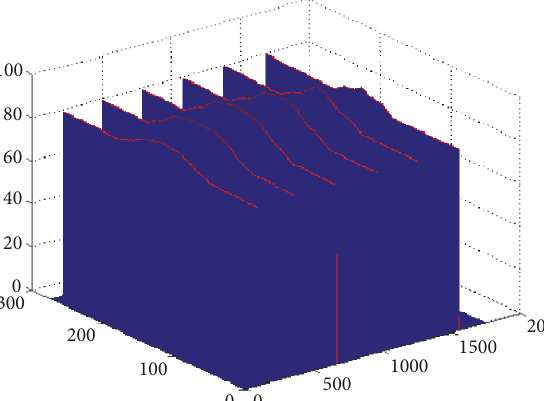
Figure 6: The effect after seeking skeleton operations.